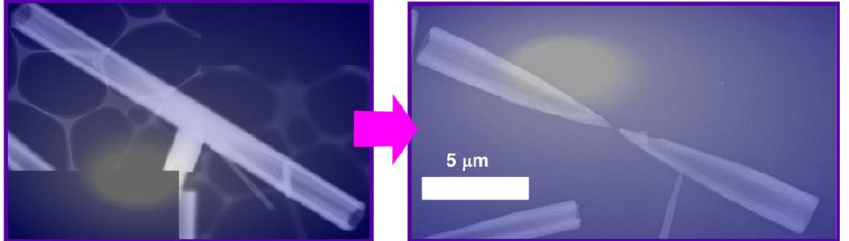
Figure 7. Fullerene micro-horns can be fabricated from fullerene micro-tubes of C 60 and C 70 mixture (these images are representative